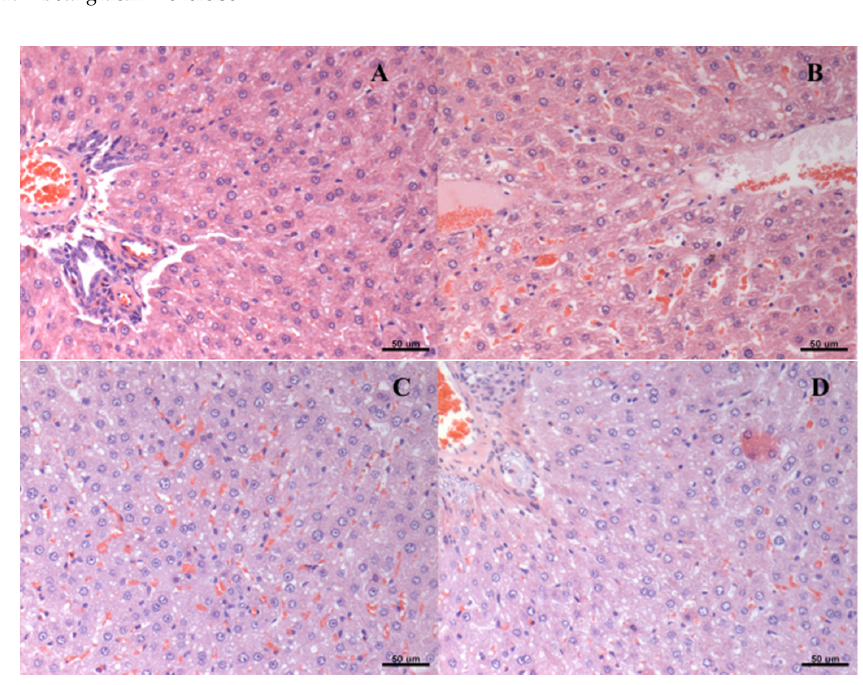
Figure 2. Histological representation (hematoxylin and eosin—20×) of degrees of hepatic steatosis in type 2 diabetic rats (HFD/STZ) submitted to physical training and/or treated with beta ‐ glucans (30 mg/kg/day). ( A ) diabetes mellitus ; ( B ) diabetes mellitus + beta ‐ glucan; ( C ) diabetes mellitus + exercise; ( D ) diabetes mellitus + beta ‐ glucan + exercise. Table 3. Degree of renal degeneration in type 2 diabetic rats (HFD/STZ) submitted to physical training and/or treated with beta ‐ glucans (30 mg/kg/day).